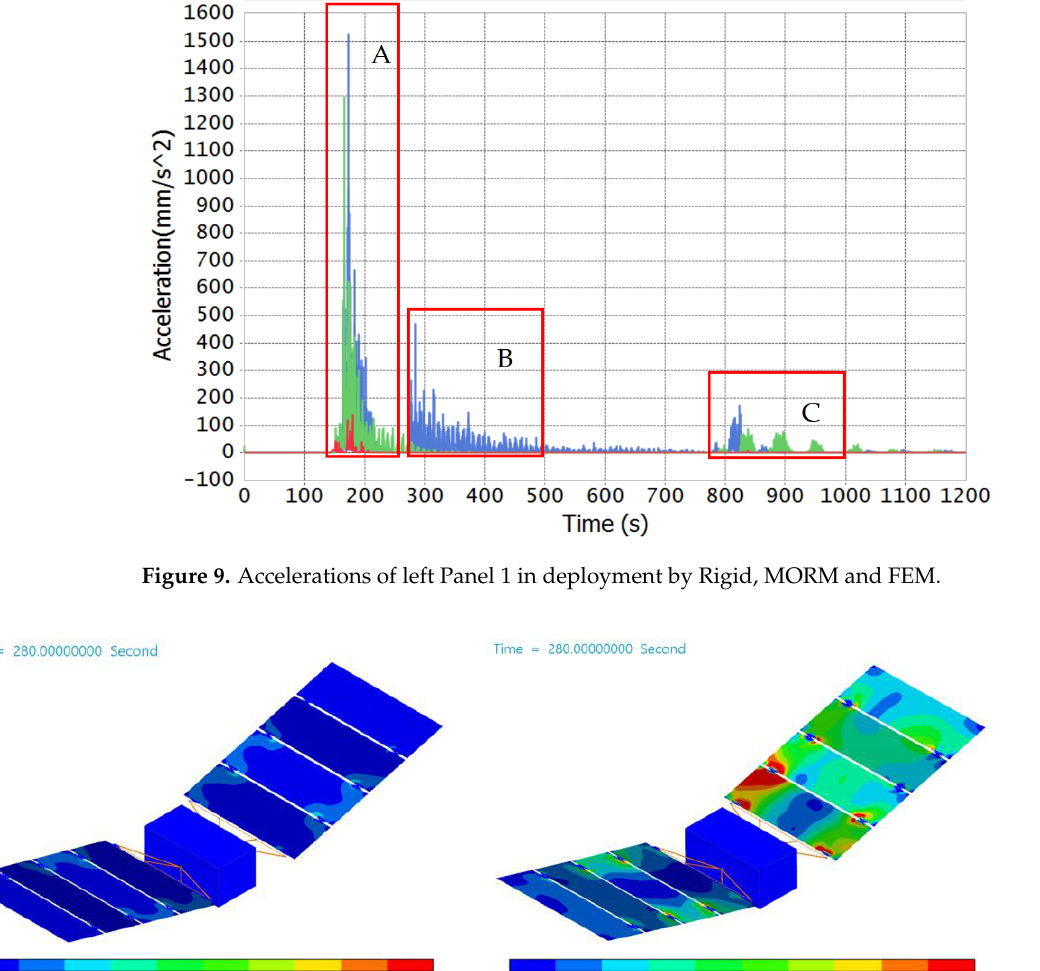
Figure 9. Accelerations of left Panel 1 in deployment by Rigid, MORM and FEM.